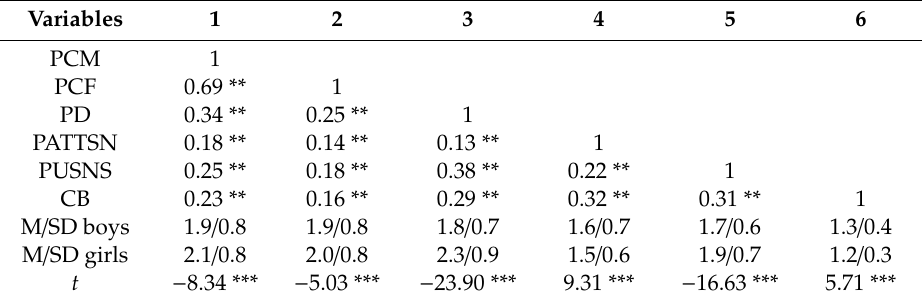
Table 1. Means, Pearson correlations, standard deviations, and Student’s t.